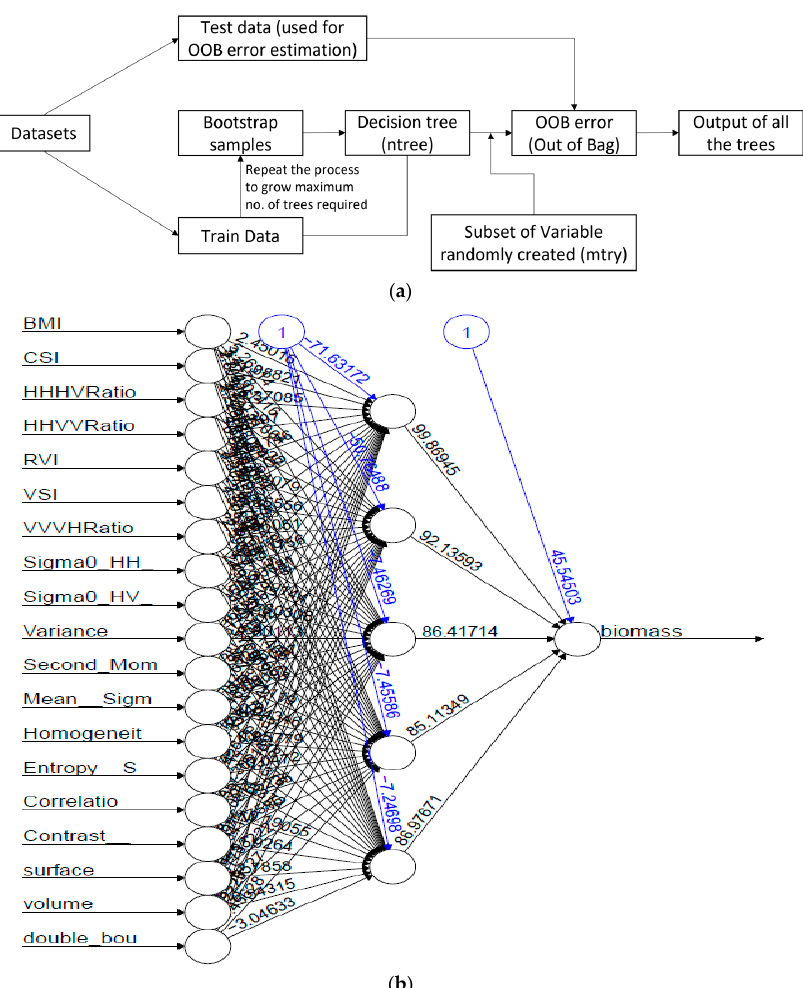
Figure 4. Workflow of ( a ) RF approach and ( b ) ANN approach for biomass prediction.